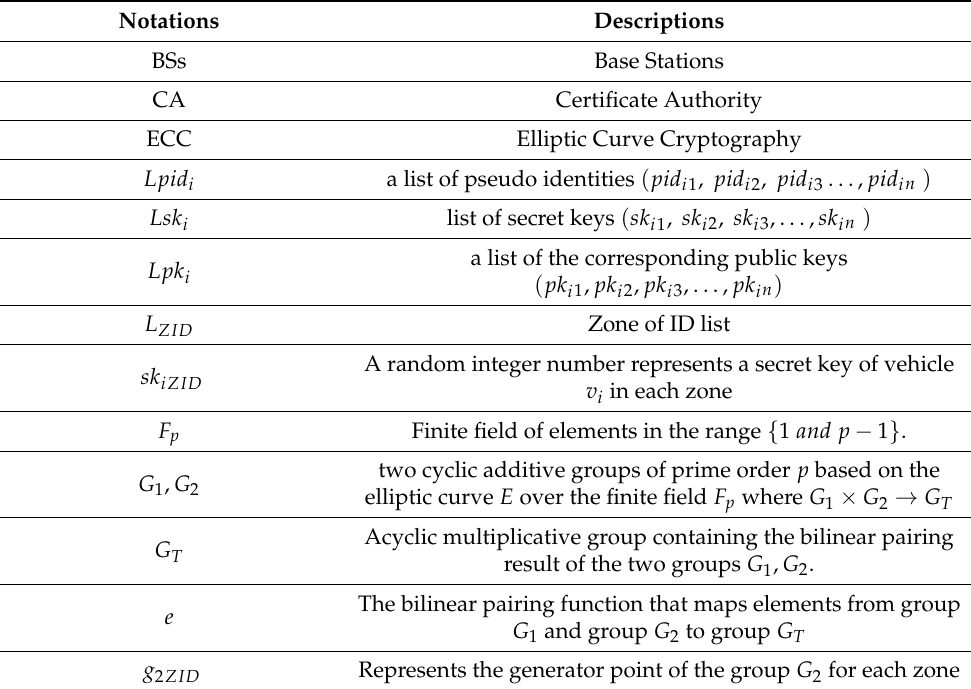
Figure 1. The proposed protocol architecture. Table 2. The system notations and abbreviations.